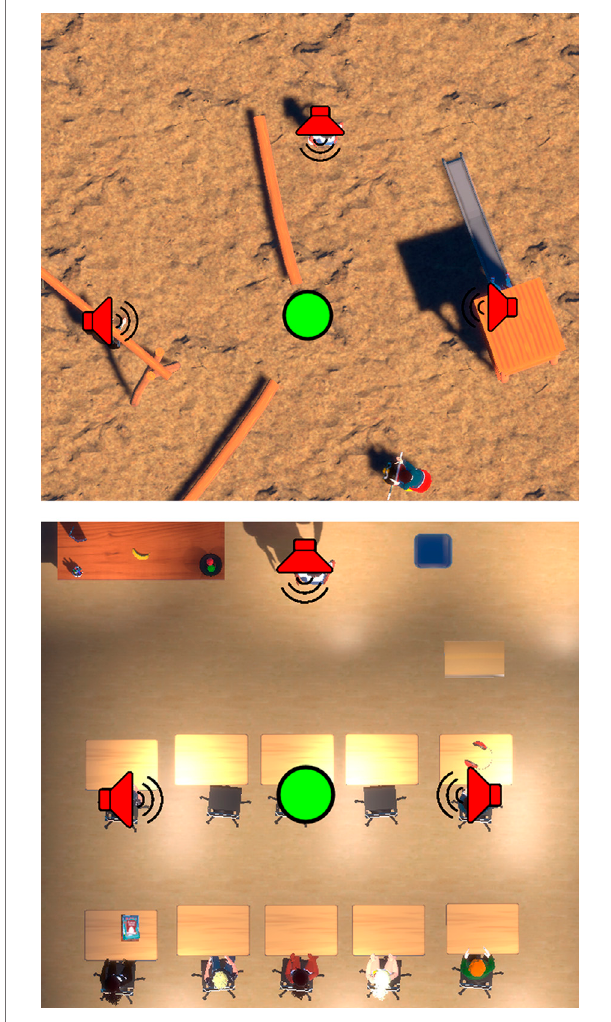
FIGURE 8 | Overviews of the two settings ( (A) the playground, (B) the classroom) in the VE. Green circles represent participants, and red speaker icons represent the three non-player characters talking during